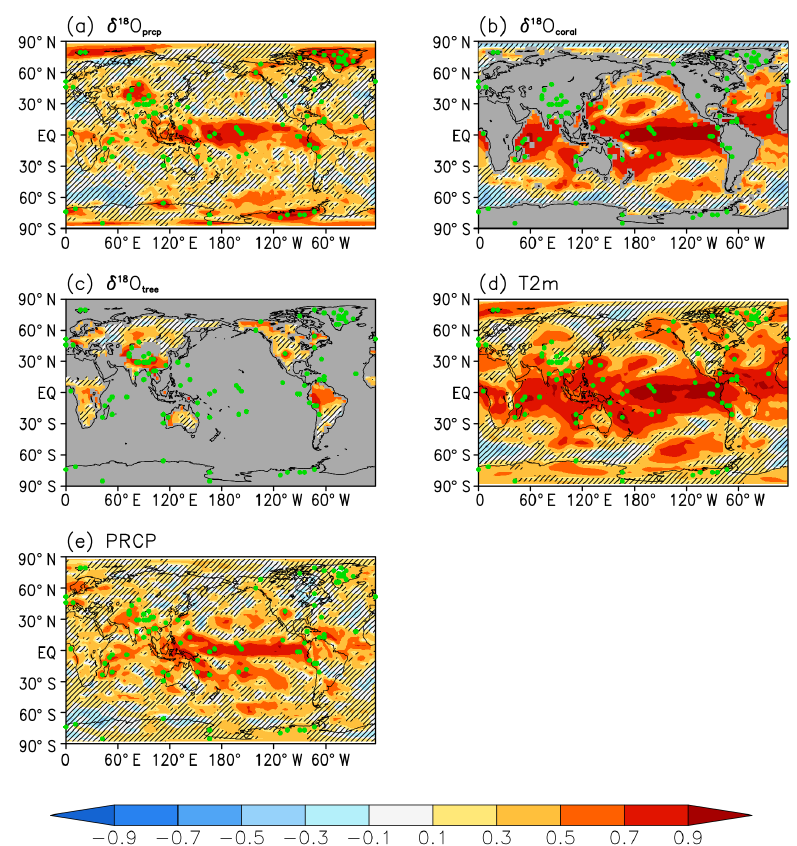
Figure 3. Temporal correlation between the analysis and the truth. The green dots represent the location of the proxy sampling site. The hatched areas indicate where the correlation is not statistically significant ( p > 0 .